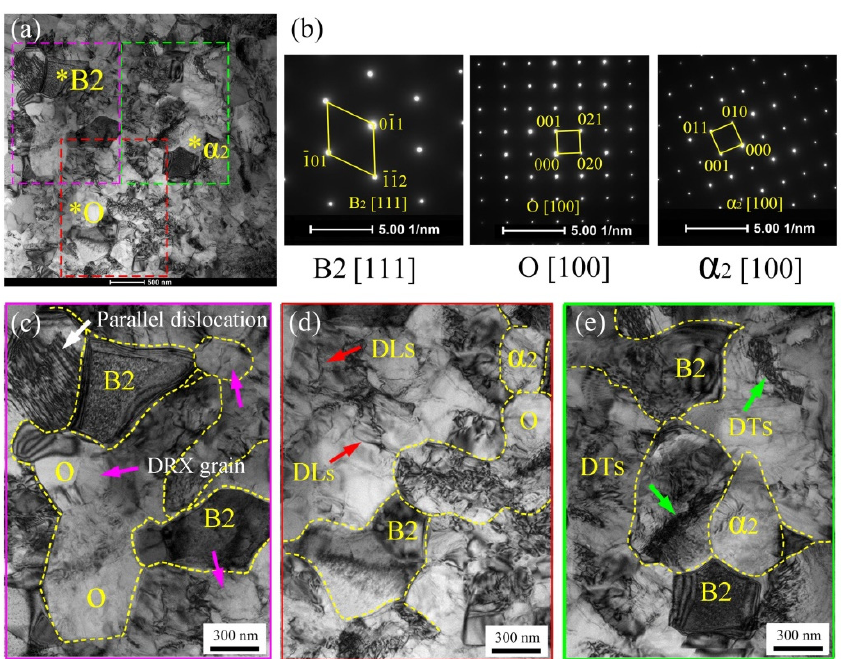
Figure 12. TEM result of the 6th pass spun tube ( ψ t = 74%): ( a ) bright field image, ( b ) selected area electron diffraction of ( a ), ( c – e ) local enlarged image with three features of ( a ). * The position marked by * corresponds to the diffraction pattern of Figure 12b.